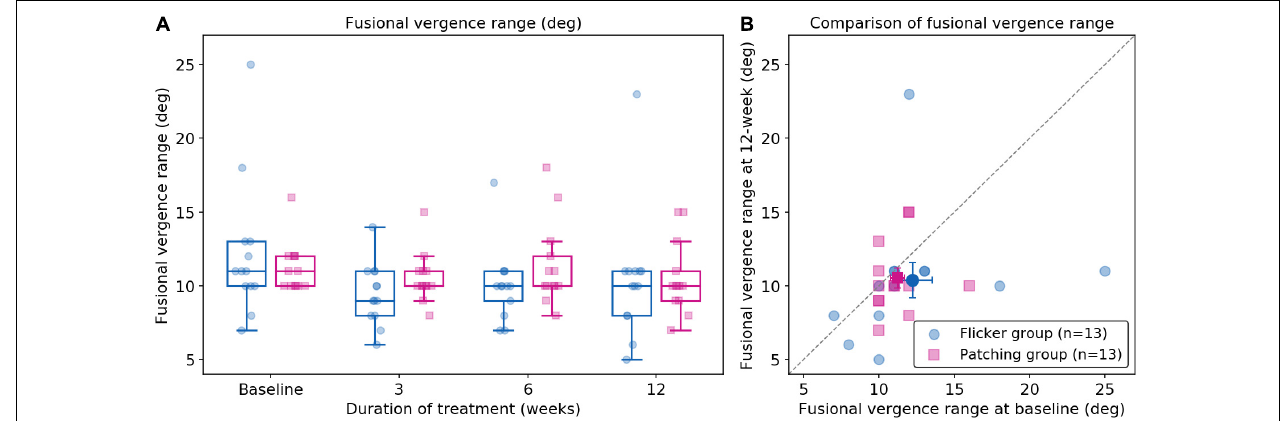
FIGURE 5 | Fusional vergence range (deg). (A) Fusional vergence range in Flicker and Patching treatment groups. (B) Individual data point of fusional vergence range measured at baseline and at 12 weeks of treatment. Both panels are plotted similarly to Figure 2